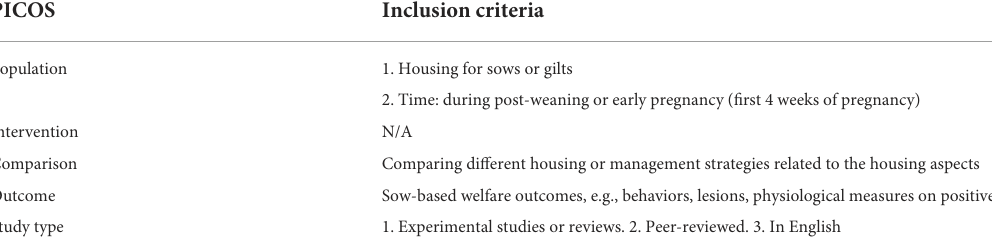
TABLE 1 Inclusion criterion based on the PICOS (population, intervention, comparison, outcome and study type) framework. PICOS